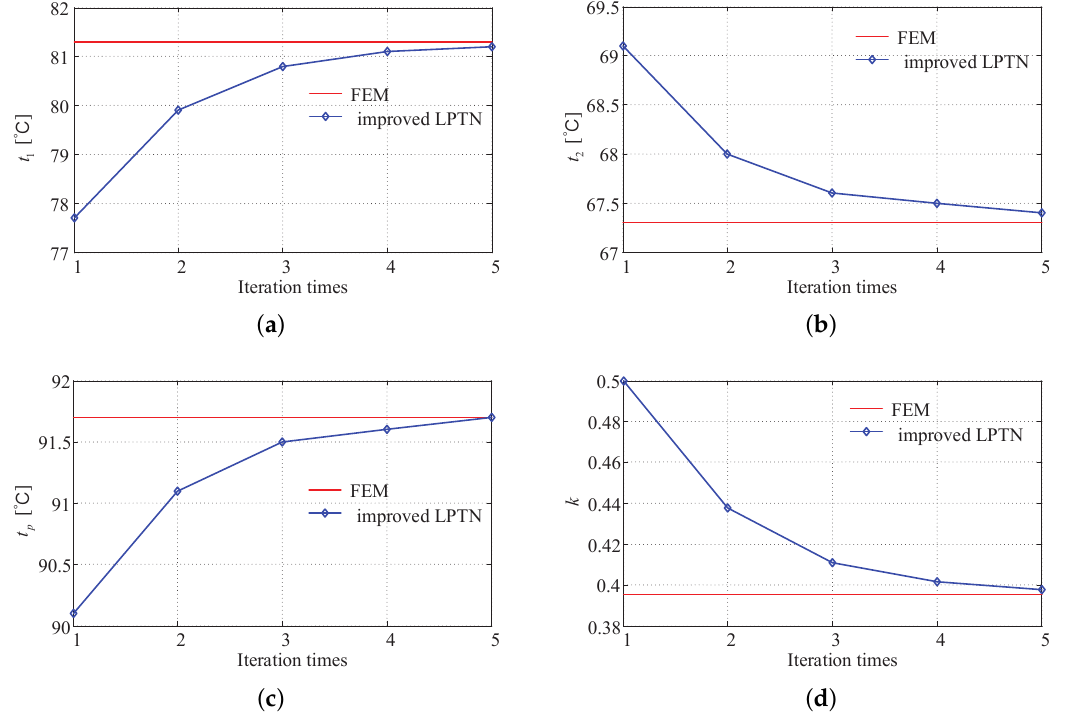
Figure 7. ( a ) Curve of temperature t 1 with iterations. ( b ) Curve of temperature t 2 with iterations. ( c ) Curve of temperature t p with iterations. ( d ) Curve of correction factor k with